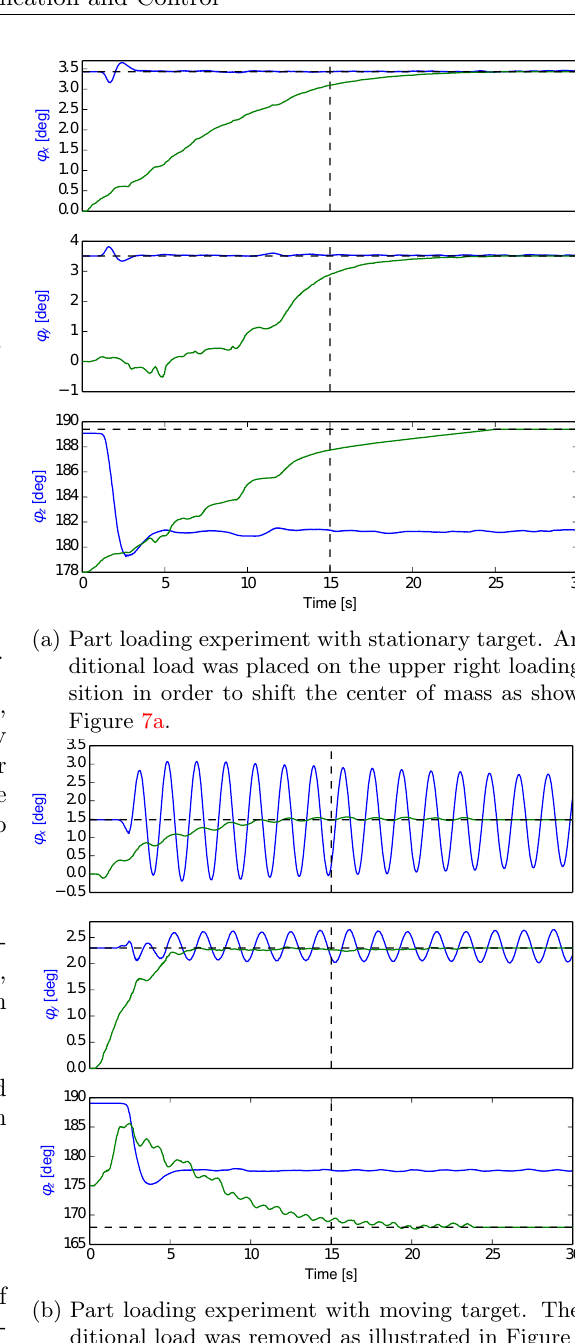
Figure 8: The graphs illustrates the result of the robot program (Figure 6). The results from Step 1 are shown as the green graphs, which dis- play the evolution of the parameter vector θ . The final values are shown as the horizontal black dashed lines. In Step 4 the end-effector was controlled according to (36), and in the interval (15 s to 30 s) the cylinder was put on the loading position on the trolley. The state vector was recorded and is shown here in blue. It is noted that the states in both Figure 8a and 8b are smooth and show no sign of